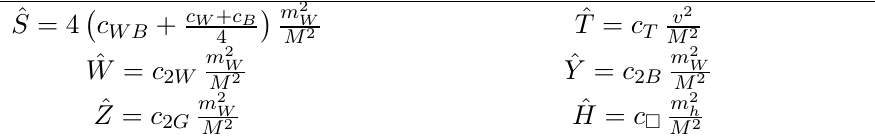
Table 1 . The complete set of CP-even operators (up to total derivatives) in the Universal basis, as they appear in the Lagrangian, divided into three classes: ‘Higgs-only’ (operators containing only the Higgs doublet and covariant derivatives), ‘gauge-only’ (operators containing gauge (cid:12)eld strengths and covariant derivatives), and ‘mixed gauge-Higgs’. The Wilson coe(cid:14)cients of ‘Higgs- only’ operators carry the power of the Higgs sector couplings (generically denoted by g in the table. The Wilson coe(cid:14)cients of ‘gauge-only’ and ‘mixed gauge-Higgs’ operators are dimen- sionless (in units of coupling). We also give the relations between oblique parameters and Wilson coe(cid:14)cients, which are valid in the Universal basis. We have chosen v (cid:25) 246